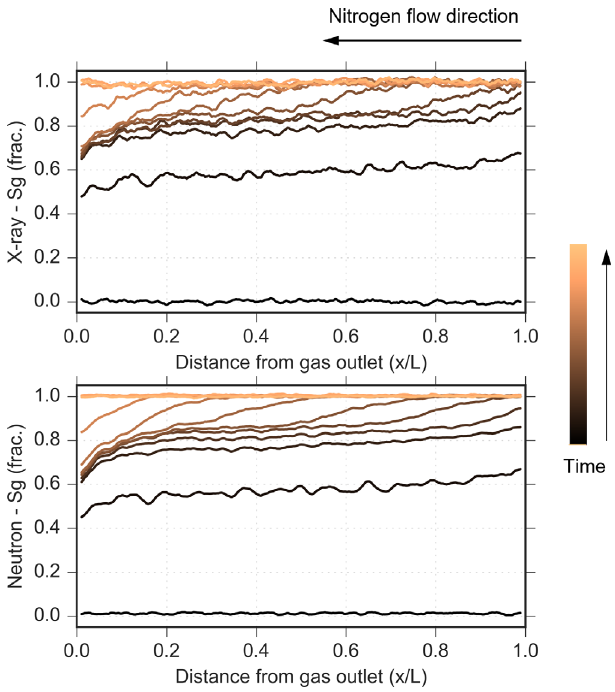
Fig. 4. X-ray and Neutron pro fi les during the dry-out with deionized water (from t = 14 min to t = 28 min). X-ray and Neutron beams are normalized between dry state and saturated with deionized water. Gas is injected from the right. Fig. 5. Dry-out with the 100 g/L KBr brine. The gas is injected into the core previously saturated with the KBr brine. The mass of salt is given for a pixel volume of 0.31